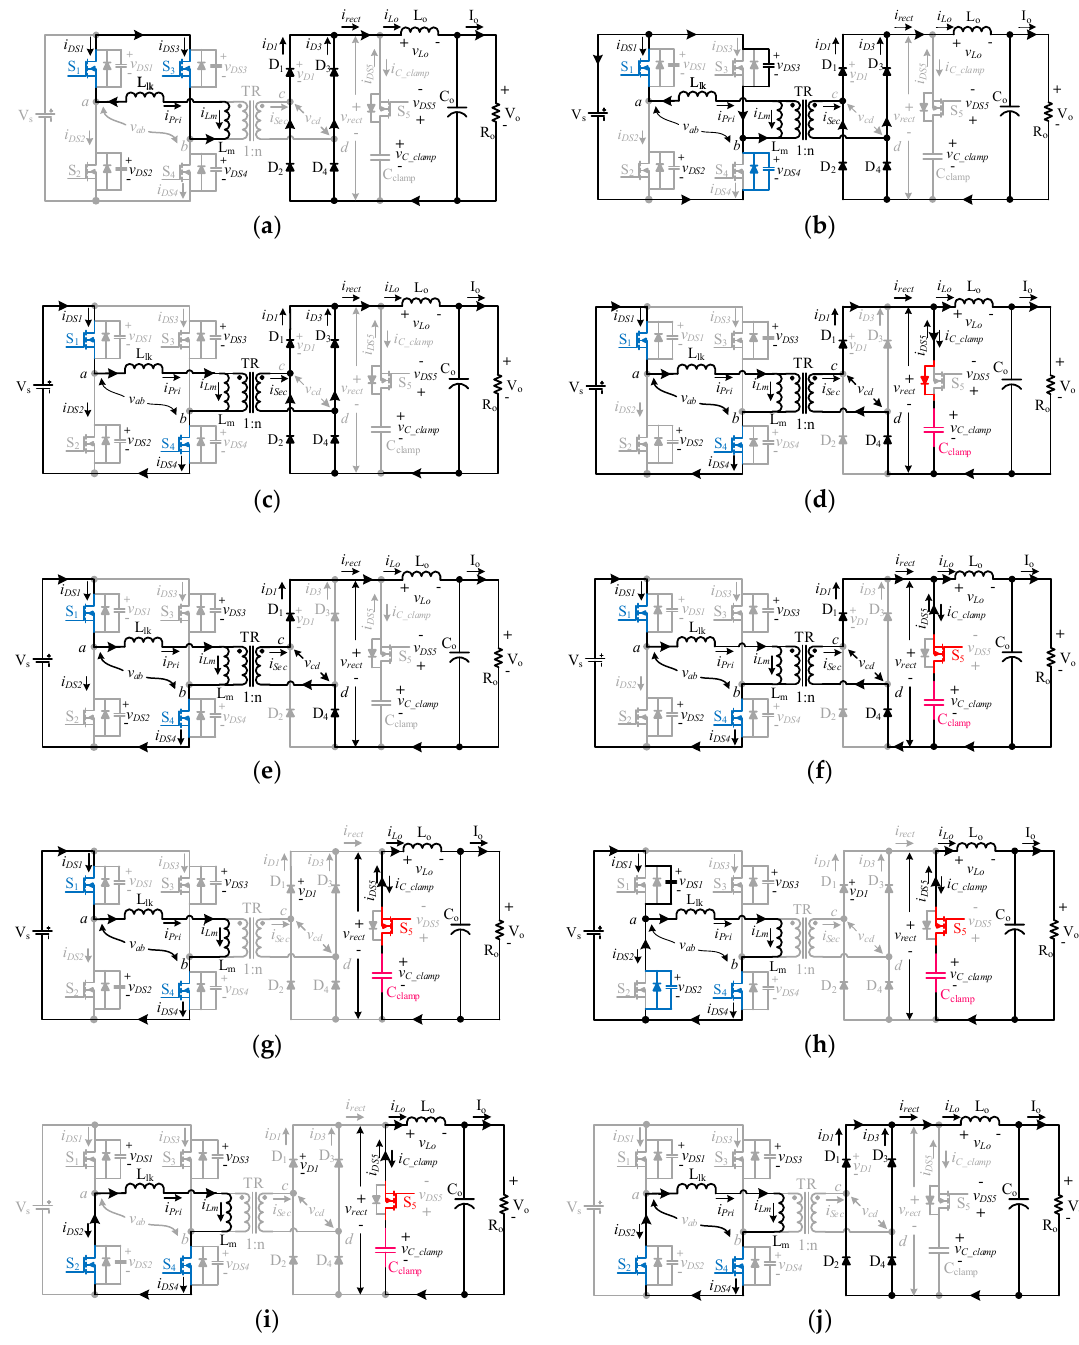
Figure 4. Equivalent circuits of the proposed converter. ( a ) Mode 0 ( Prior to t 0 ) ; ( b ) Mode 1 ( t 0 − t 1 ) ; ( c ) Mode 2 ( t 1 − t 2 ) ; ( d ) Mode 3 ( t 2 − t 3 ) ; ( e ) Mode 4 ( t 3 − t 4 ) ; ( f ) Mode 5 ( t 4 − t 5 ) ; ( g ) Mode 6 ( t 5 − t 6 ) ; ( h ) Mode 7 ( t 6 − t 7 ) ; ( i ) Mode 8 ( t 7 − t 8 ) ; ( j ) Mode 9 ( t 8 − t 9 )